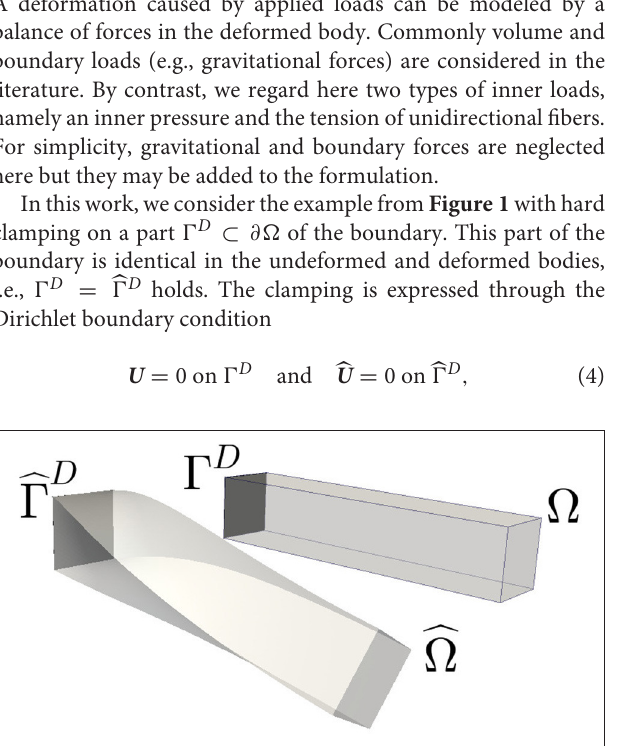
(cid:127) Ŵ D where the b = b